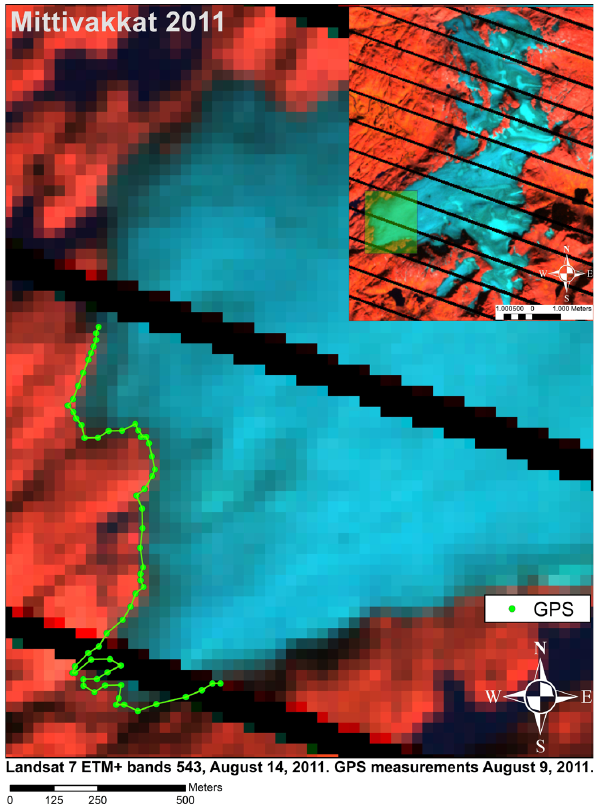
Fig. 3. A comparison between the Landsat-derived Mittivakkat Gletscher margin and the observed margin based on portable GPS observations (green line with dots) for August 2011. The inset fig- ure indicates the location of the observed margin at Mittivakkat Gletscher. The oblique black lines are due to the SLI